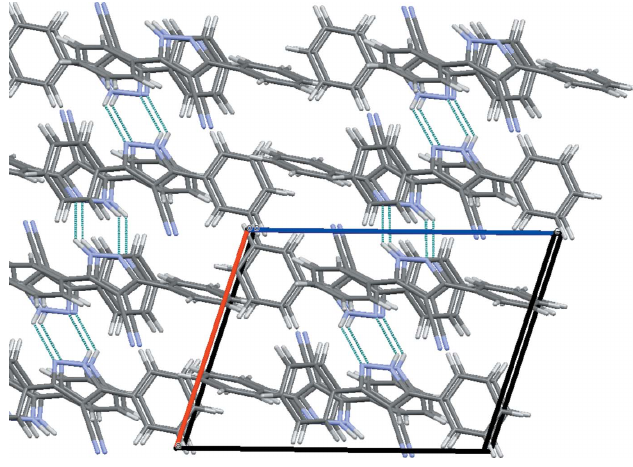
Figure 2 A view along the b axis of the crystal packing of the title compound. The N—H (cid:2)(cid:2)(cid:2) N hydrogen bonds (Table 1) are shown as dashed